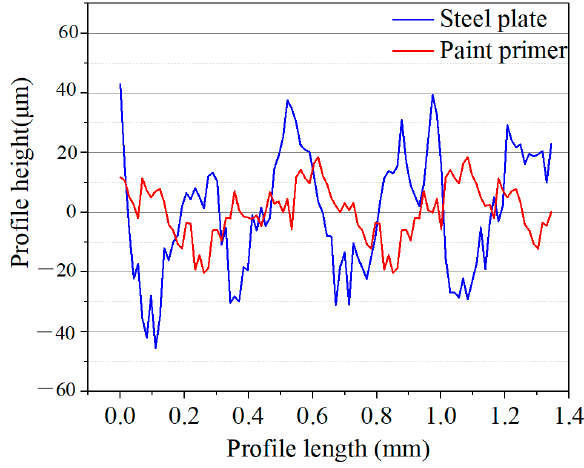
Figure 13. Comparison of the profiles of the steel plate surface without and with primer spray.